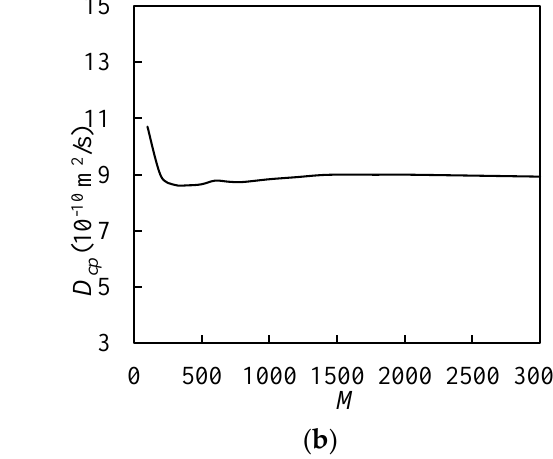
Figure 9. Determination of the values of M and R 0 . 4. Verification and Discussion To verify the numerical simulation results, a set of tests were carried out using the NEL method [8]. The acceleration equipment is shown in Figure 10a. The cement paste specimen was poured into Φ100 × 100 mm cylinders; Portland cement P-O 42.5 (Zhejiang